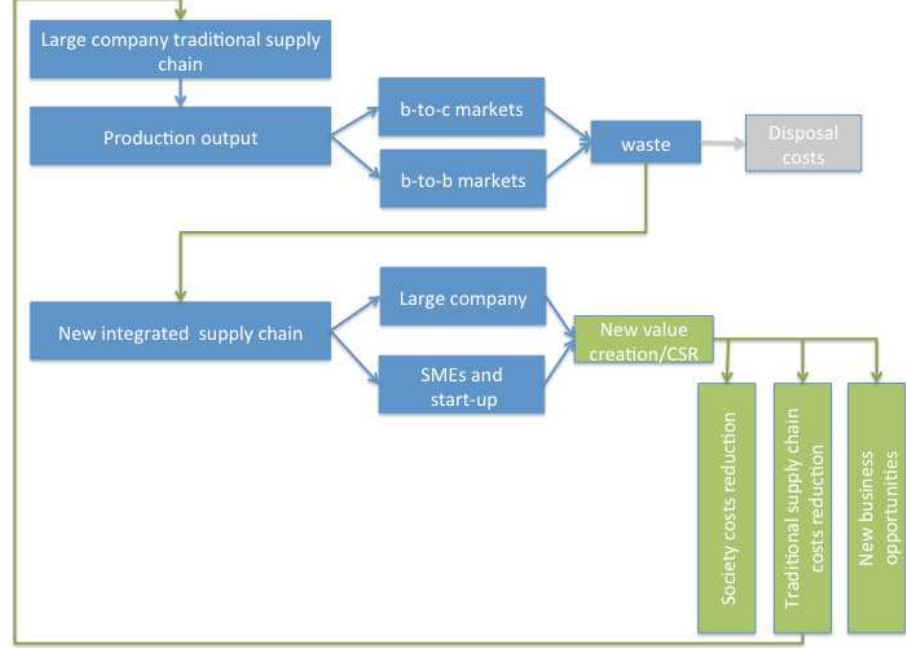
Figure 2: A Sustainable Business Model Starting from the